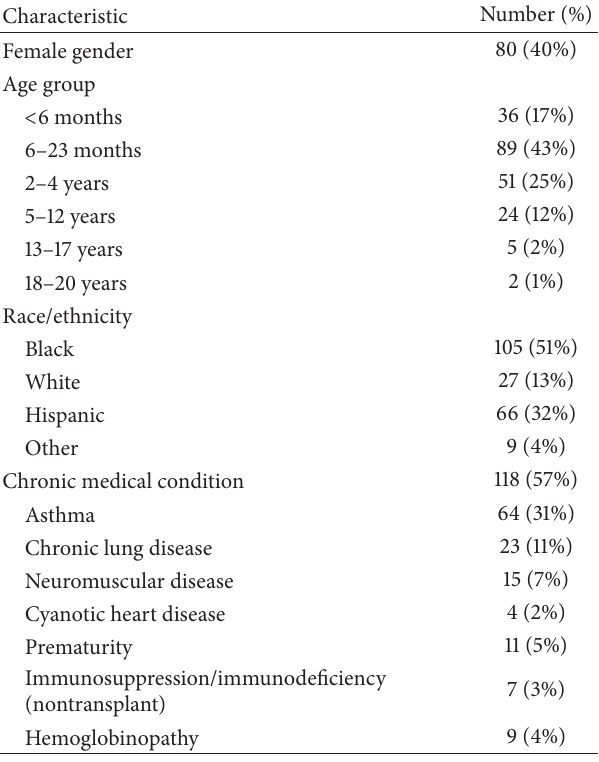
Table 1: Characteristics of patients hospitalized with human metap- neumovirus